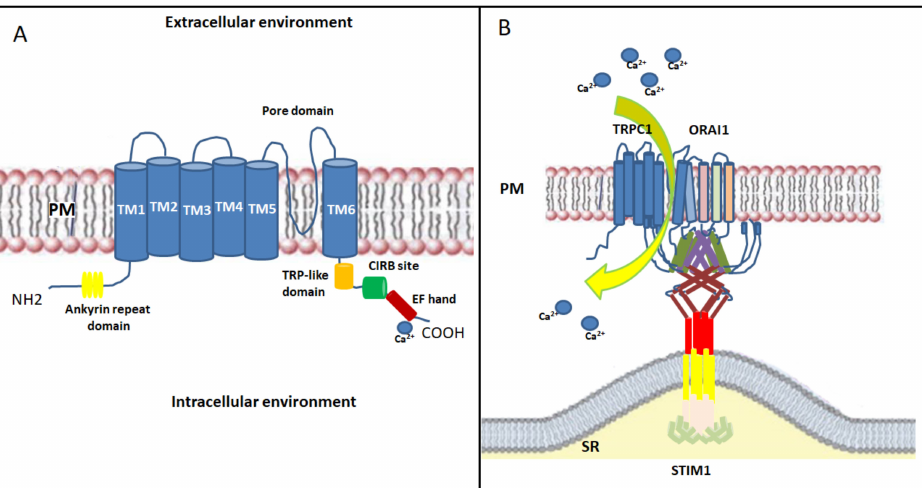
Figure 3. ( A ) Schematic representation of the structure of TRPC channels with the six transmembrane (TM) regions, the N - terminus containing ankyrin repeat domain and C -terminus containing TRP-like domain, the calmodulin/inositol 1,4,5-trisphosphate receptor-binding (CIRB) site and the EF-hand. ( B ) Schematic model of the proposed interaction between STIM1/Orai1/TRPC1 in a dynamic STIM1- Orai1-TRPC1 ternary complex as SOC-channel. PM—plasma membrane; TM—transmembrane; TRPC1—transient receptor potential channels 1; STIM1—stromal interaction molecule